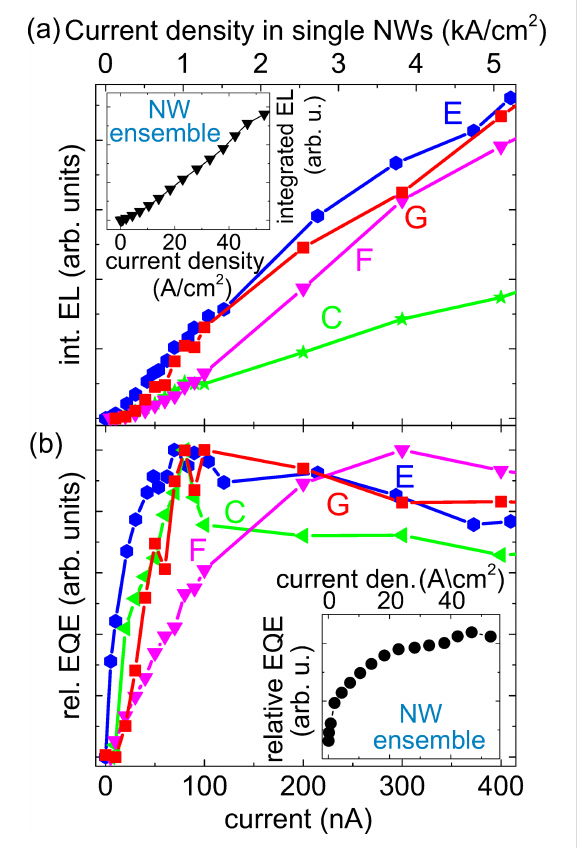
Figure 6: (a) Integrated EL and (b) normalized relative EQE of the measurement points C, E, F, and G as a function of the current. The respective insets in the graphs (a) and (b) show the integrated EL and relative EQE of the NW ensemble